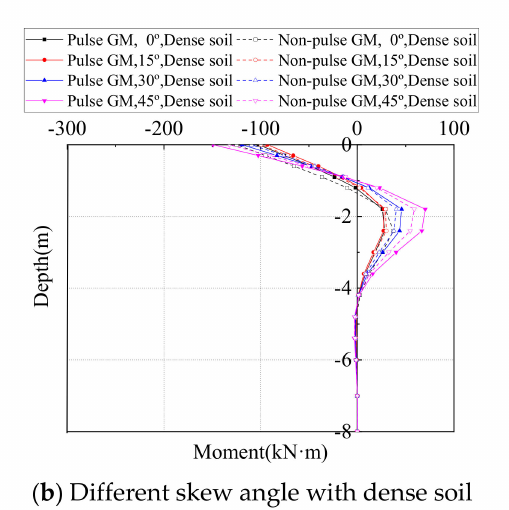
Figure 18. Distribution of pile moment around the weak axis.